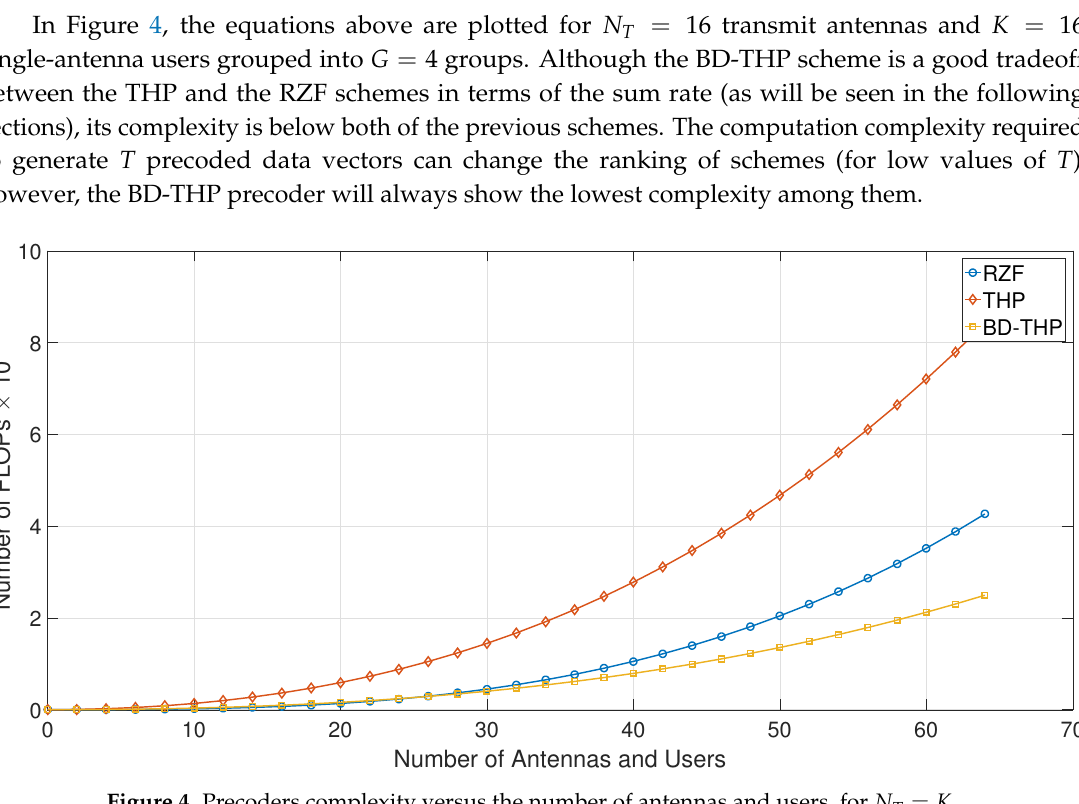
Figure 4. Precoders complexity versus the number of antennas and users, for N T = K